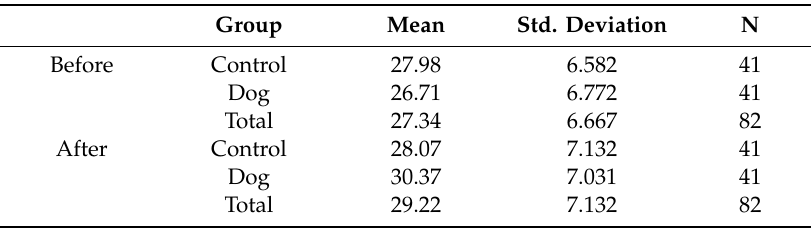
Table 4. Descriptive Statistics: General Positive A ff